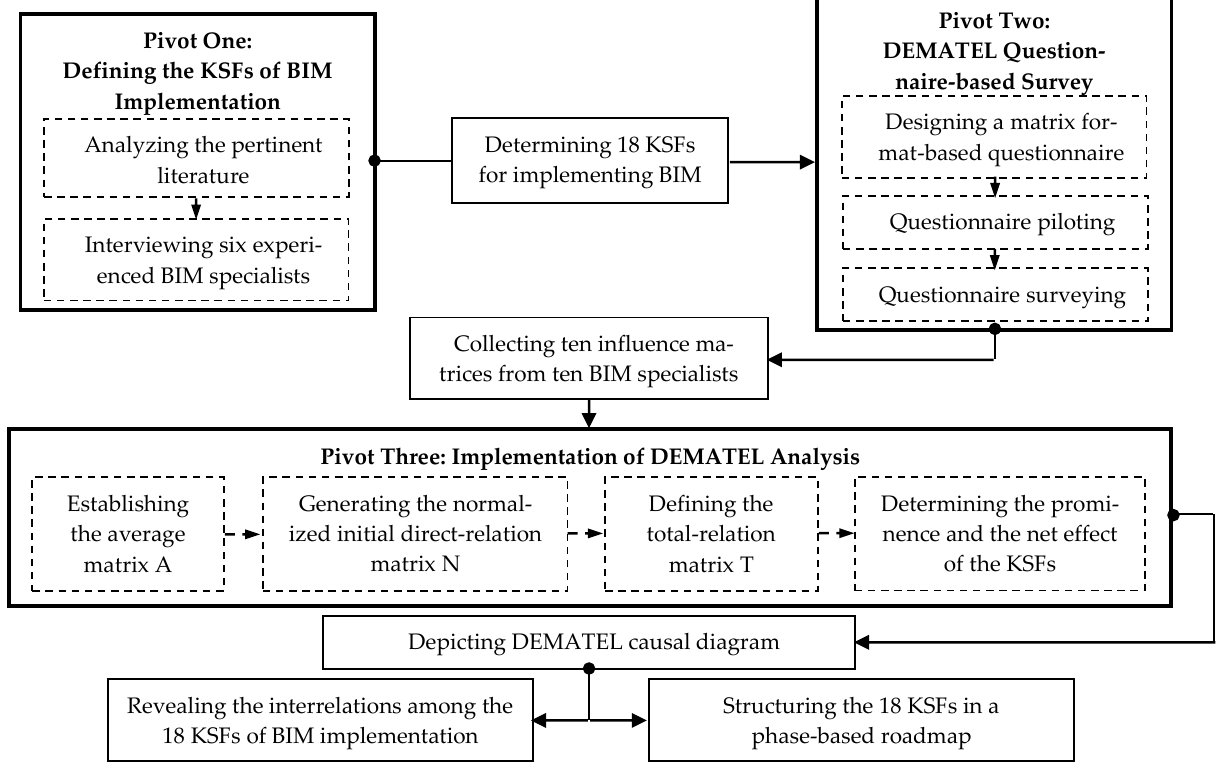
Figure 1. Pivots of the research methodology.